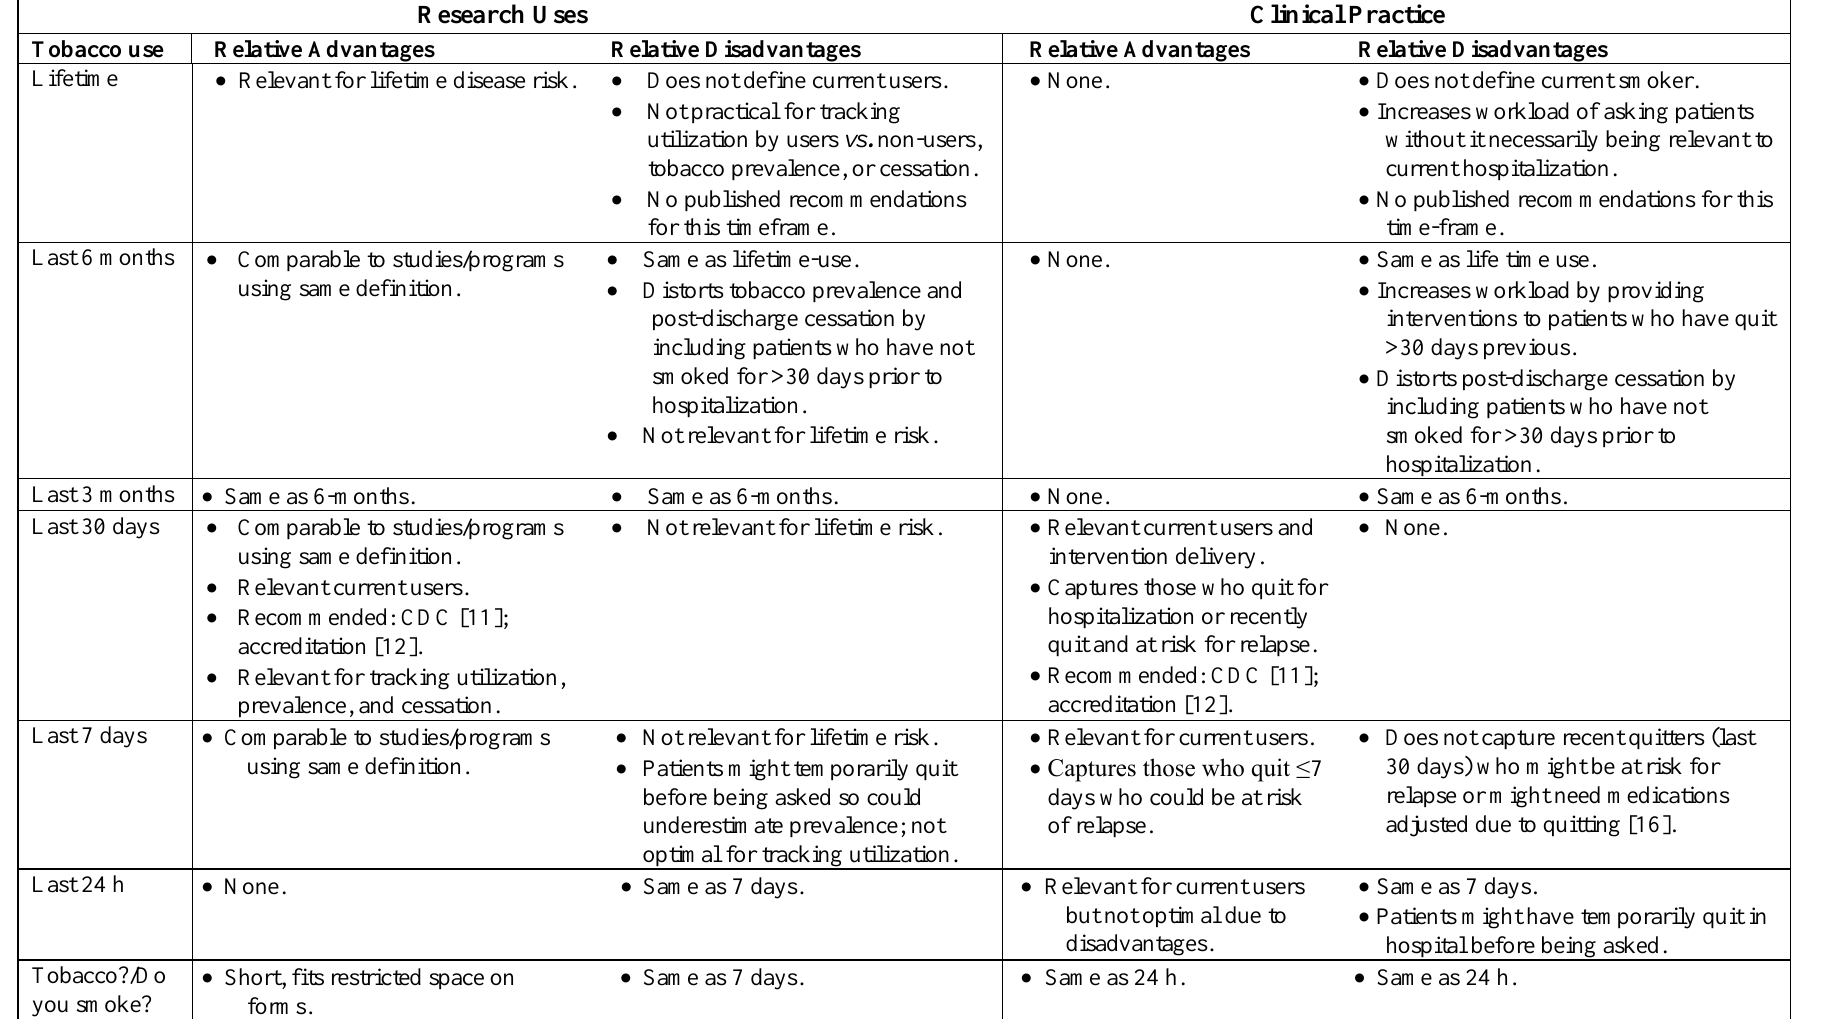
Table 1. Considerations of different tobacco use questions in research and